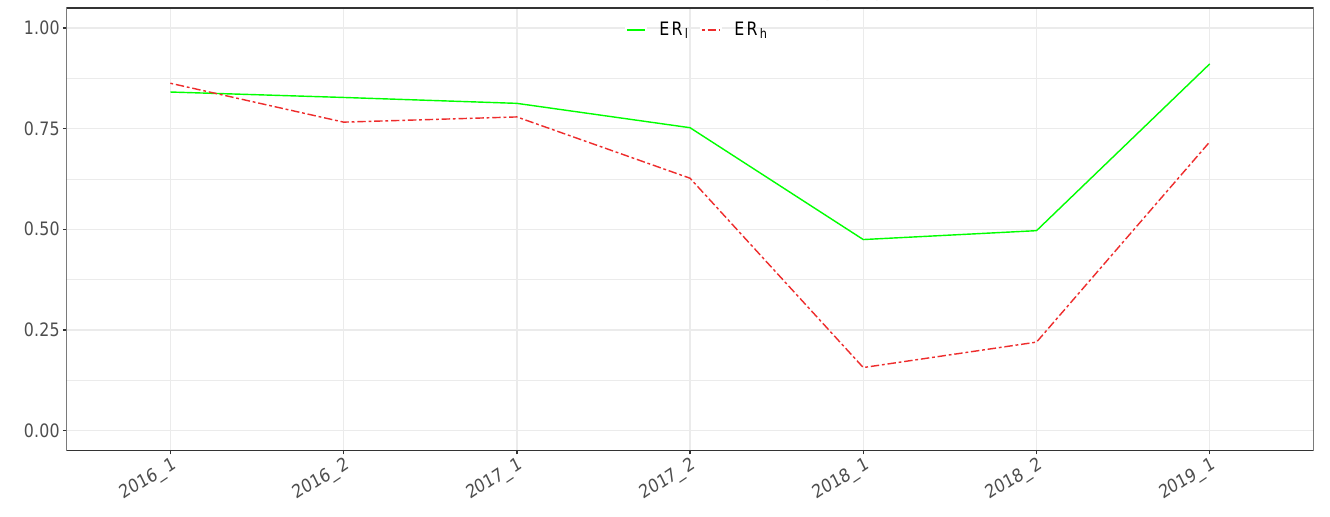
Figure 5. Value of the academic performance indicator by economic risk. The percentages of students appearing in each group (Excellence, Fail or Expect) show disparate results depending on the semester analyzed, but in all of them, students who do not participate in actions present a higher percentage of Excellence (Table 9). For example, in 2016_2, the percentage of Excellence among students who did not participate in any action was 64.62%, while that of those who participated in at least one was 39.81%. Surprising again, of the few students who have an Excellence score in the results obtained for the 2018_1 and 2018_2 semesters, 8.33% and 38.46% did not participate in complementary actions and 3% and 1.26% did participate. Above all, the percentage of students in the Fail situation, 41.67% and 23.08% in the group of those who do not participate and 49.50% and 40.69% of those who have participated in some complementary action, is surprising in these